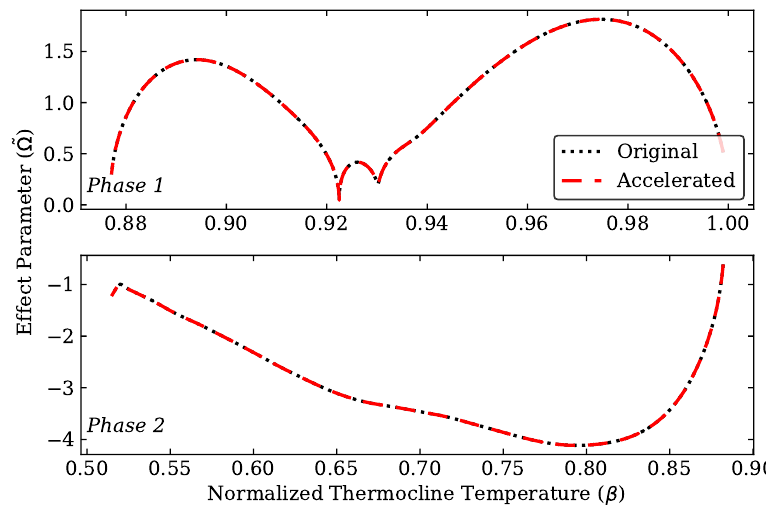
Figure 9. Scaled process curves of discharging mode at the